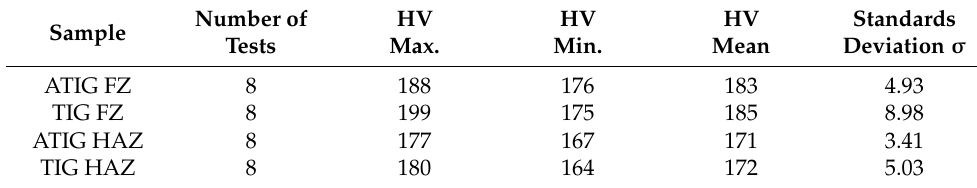
Table 12. Hardness values and standards deviation of TIG and ATIG.